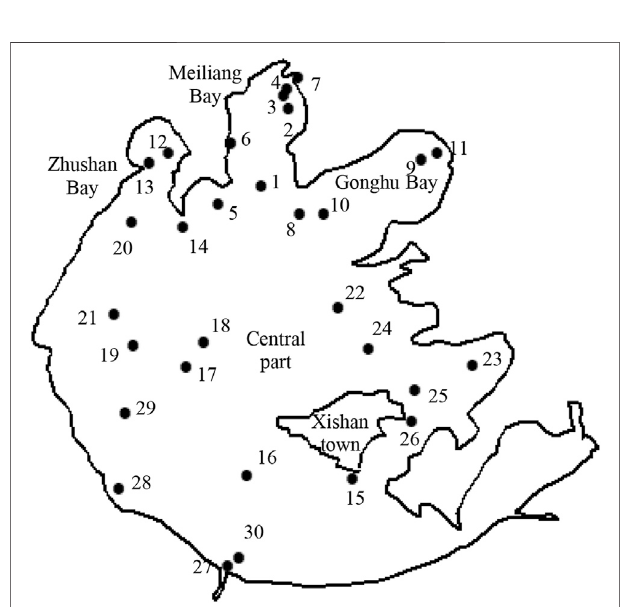
Frontiers in Environmental Science |